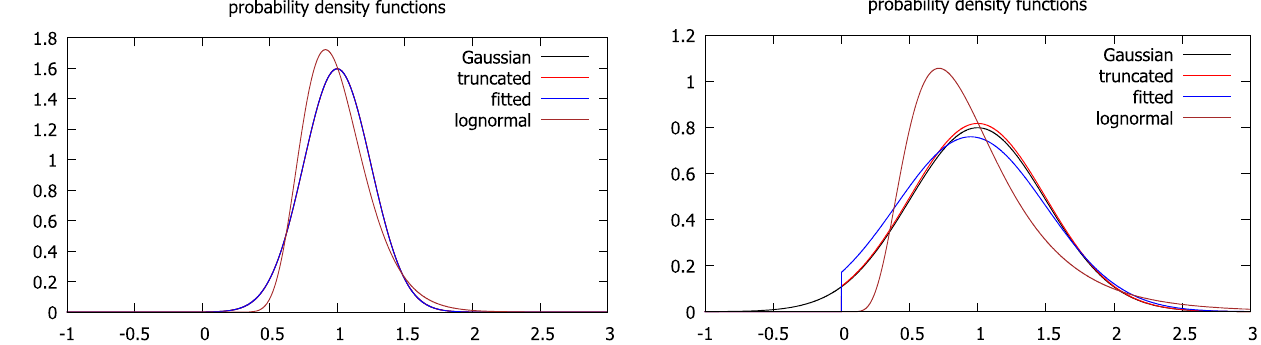
Fig. 5. Candidate law probability density function for relative standard deviation of 25% (left) and 50% (right).